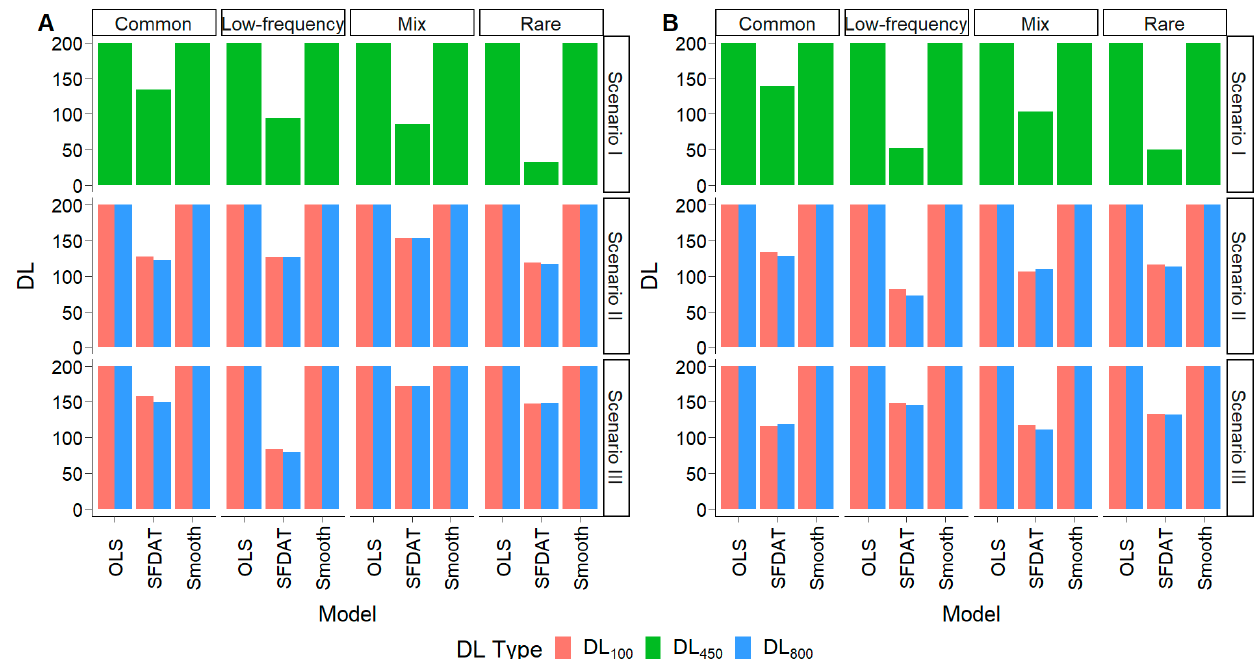
Figure 3. The simulation DL of four variants using OLS, SFDAT and Smooth under three scenarios of Case I. DL 100 , DL 450 , DL 800 denotes the discovery length for non-zero region at locus 100, 450 and 800, respectively. ( A ): The situation of linkage equilibrium; ( B ): the situation of linkage disequilibrium; Scenario I: Set a positive causal SNP at locus 450 in the gene region. Scenario II: Set a positive causal SNP at locus 100 and 800 in the gene region, respectively. Scenario III: Set a positive causal SNP and a negative causal SNP at locus 100 and 800 in the gene region, respectively.